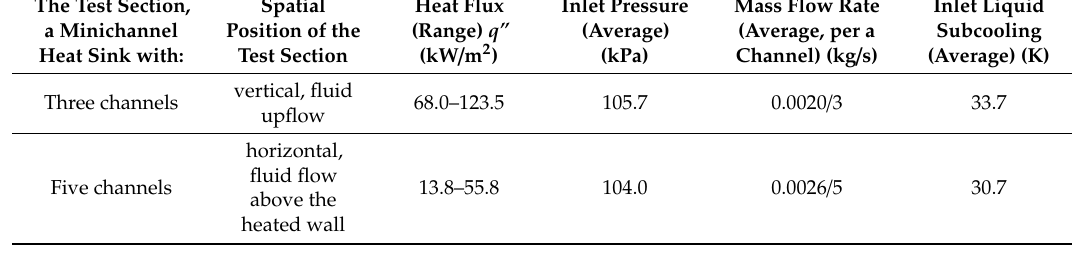
Figure 7. Distribution of y -component of fluid velocity obtained from the FEM computations carried out by ADINA software: ( a ) the test section with three minichannels, q’’ = 68 kW/m 2 ; ( b ) the test section with five minichannels, q’’ = 13.8 kW/m 2 ; other experimental parameters are listed in Table 2.